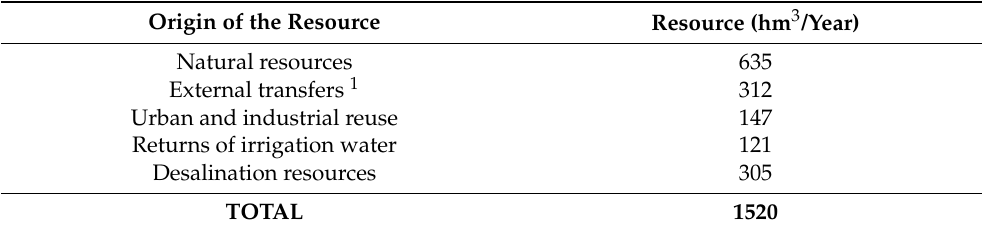
Table 1. Total resources of the SRB. Source: own elaboration based on [32]. Origin of the Resource Resource (hm 3 /Year) Natural